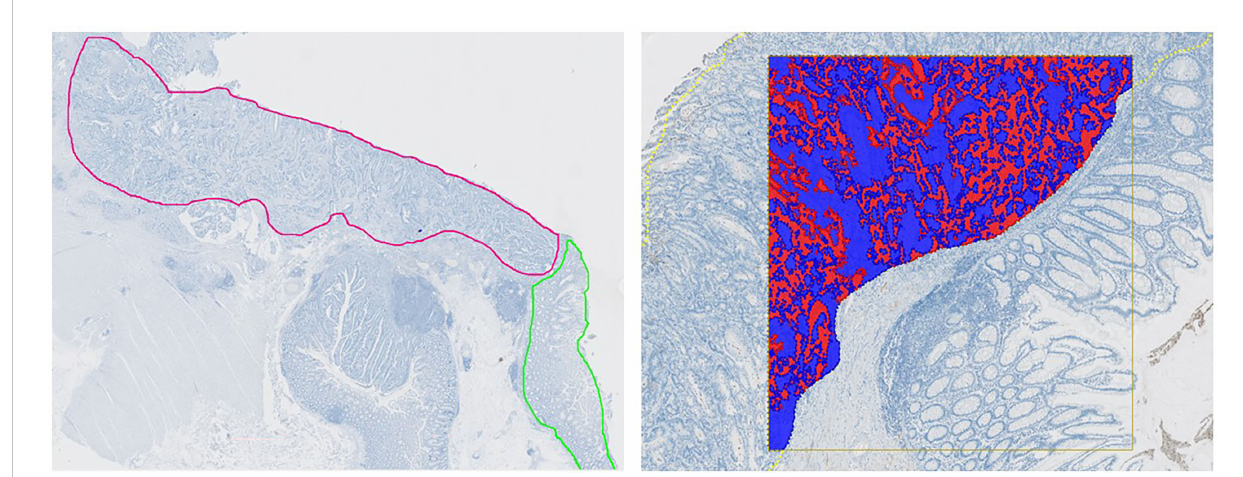
FIGURE 1 Automated Image Analysis Work fl ow. Left: Whole slide image with annotated tumor regions. Tumor in red and adjacent normal colon mucosa in green. Right: An AI-based algorithm was developed for analyzing the pattern of mCRP distribution and accurately segment tumor epithelium (red) and tumor stroma